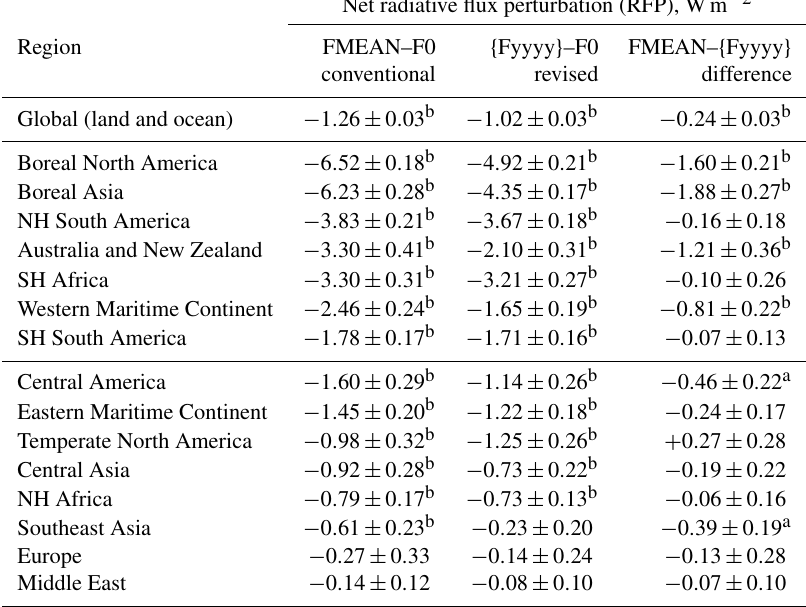
Table 1. Net (shortwave plus longwave) top-of-atmosphere radiative flux perturbation (RFP) differences for different simulation combina- tions and regions (see Fig. 1). Area-weighting has been applied. Combined standard errors have been calculated using corrected sample standard deviations, using annual regional mean data as the input – e.g. the standard error for the global { Fyyyy } –F0 difference was calcu- r 2 s 2 { Fyyyy } + s F0 lated using , where s { Fyyyy } and s F0 are the corrected sample standard deviations, and N { Fyyyy } = 120 and N F0 = 42 are the N { Fyyyy } N F0 sample sizes. Significance has been tested using Welch’s t test, using annual regional mean data as the input: a indicates differences that are statistically significant at two-tailed p < 0 . 05, and b indicates differences that are statistically significant at two-tailed p < 0 . 01. The regions have been ranked according the FMEAN–F0 net RFP strength. A horizontal line is used to indicate the seven regions that receive more focus in the Results